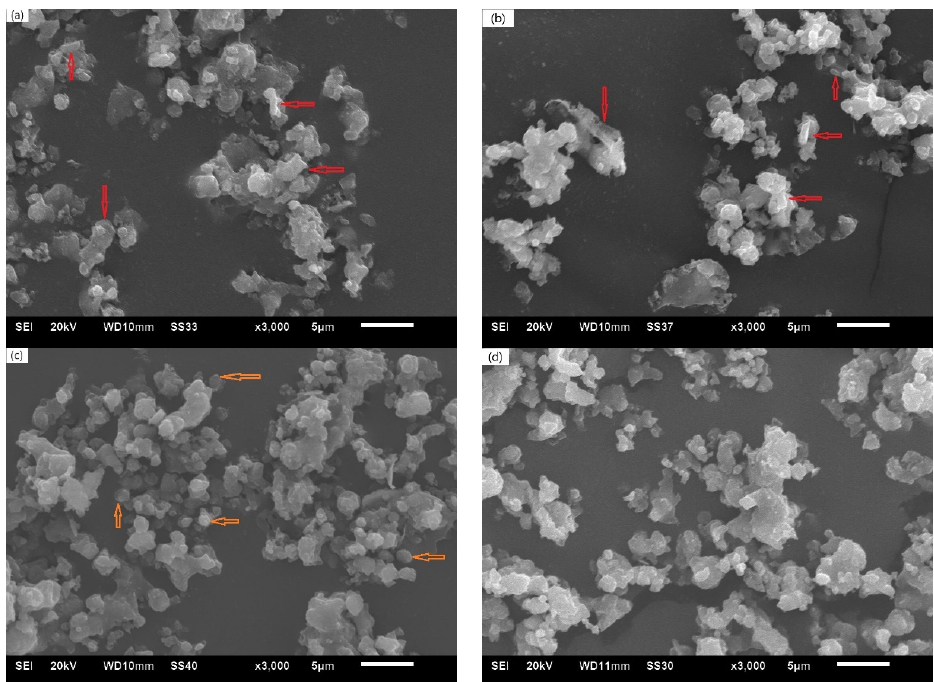
Figure 2. SEM images of samples sintered at different temperatures for 2 h: ( a ) 700 °C, ( b ) 800 °C, ( c ) 900 °C and ( d ) 1000 °C. Scale bars: 5 µM.